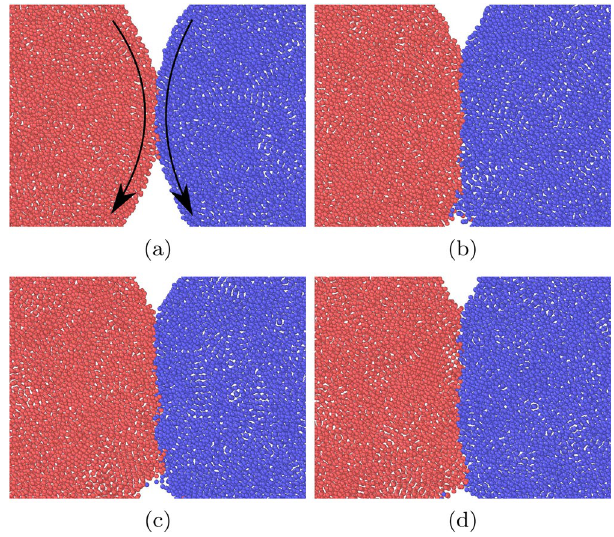
Figure 7. Snapshots of a rolling simulation with ǫ 12 = 0.75 for an initial value of the angular velocity ω = 0.04 . Snapshots ( a , b , c , d ) are spaced by (cid:31) t = 46.4 . The arrows in ( a ) indicate the rotation direction, see Fig. 1a. In all subpanels, the spheres are aligned such that the central axis lies horizontally in the middle of the figure.